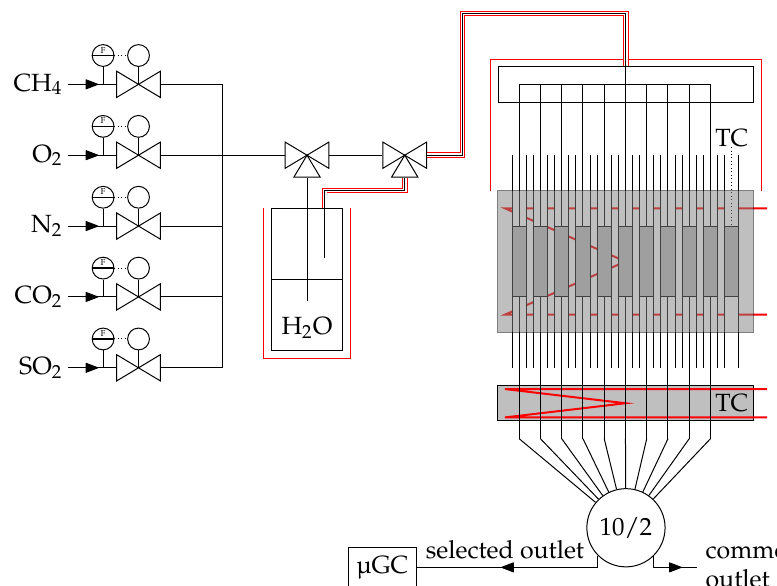
Figure 21. Scheme of setup to determine ageing behavior of up to 10 different